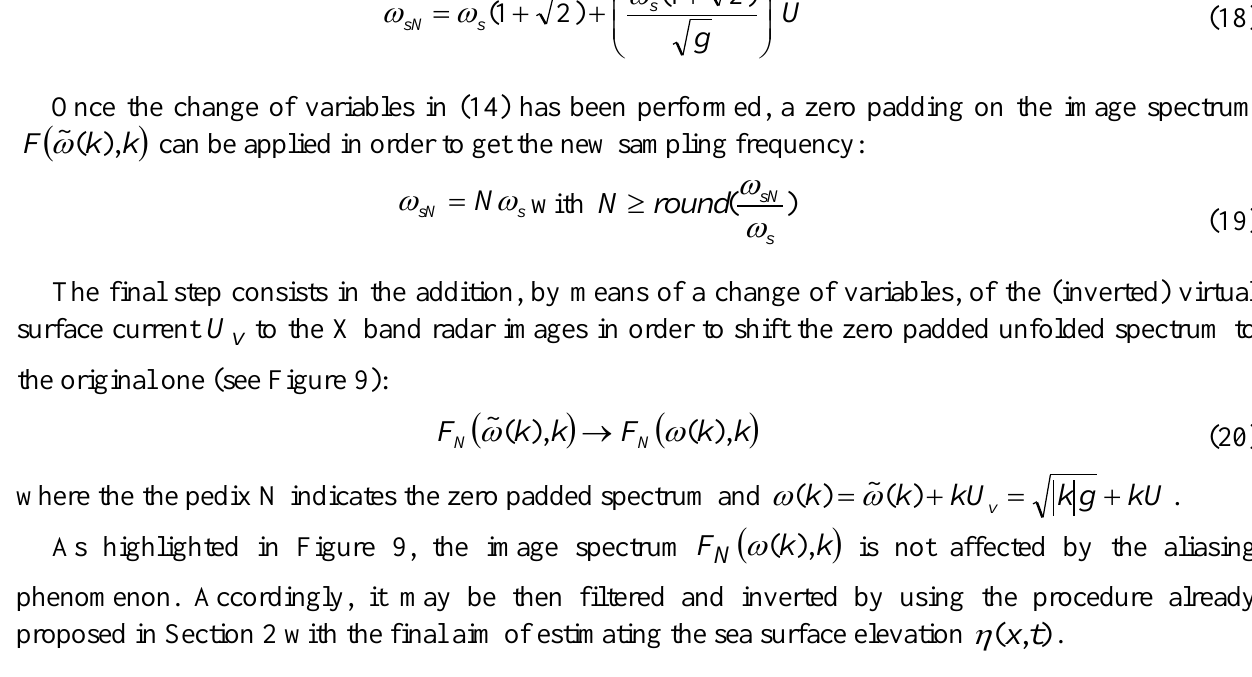
Figure 9. Zero padded non-folded spectrum   kkF